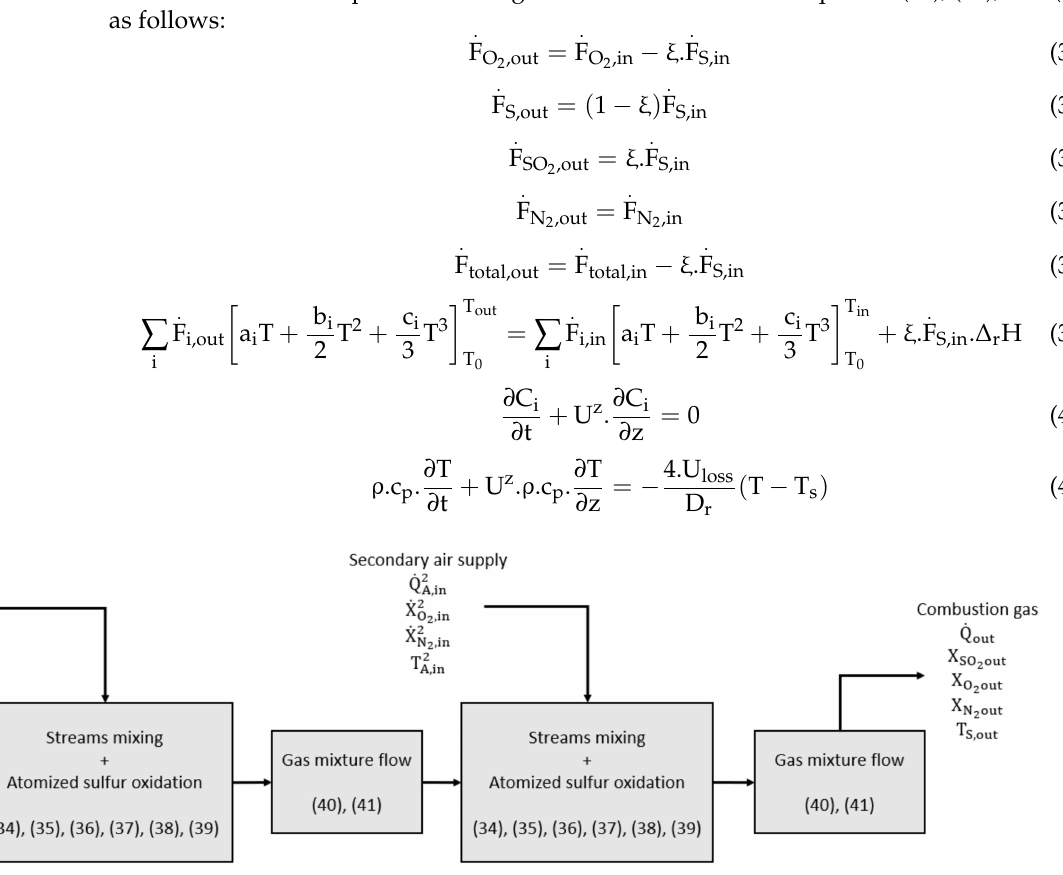
Figure 3. Sulfur combustion furnace model block